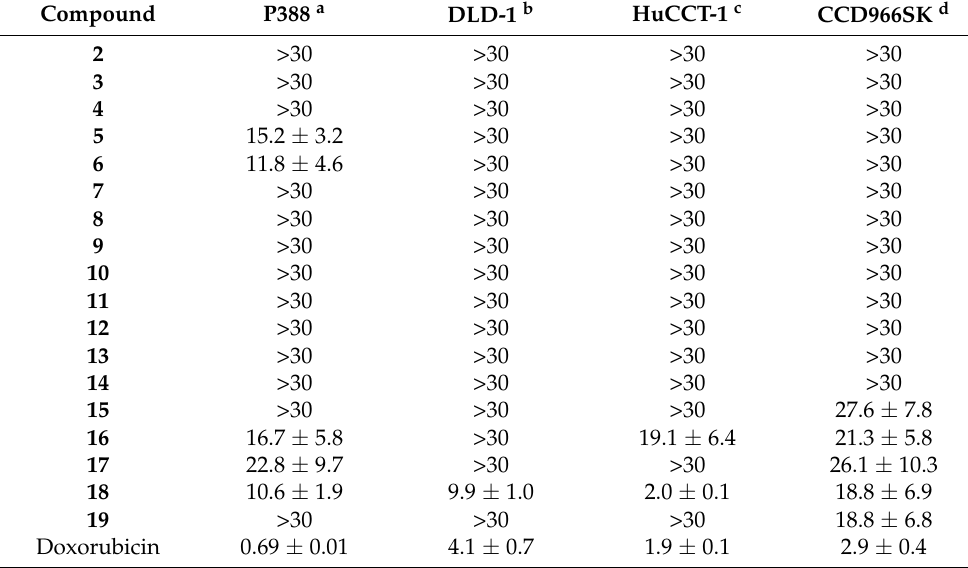
Table 4. Anti-proliferation activities (IC 50 , µ M) of 2 – 19